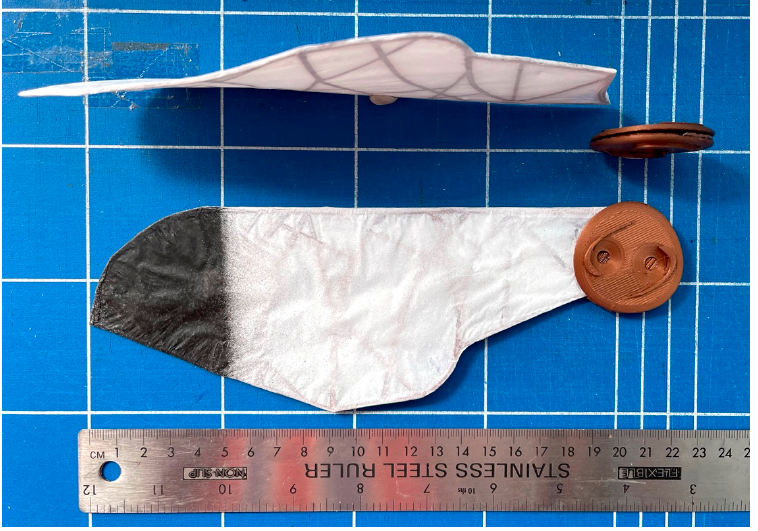
Figure 6. Photograph of TA1. The probe head has holes which would be used for sample collection in large probe design.